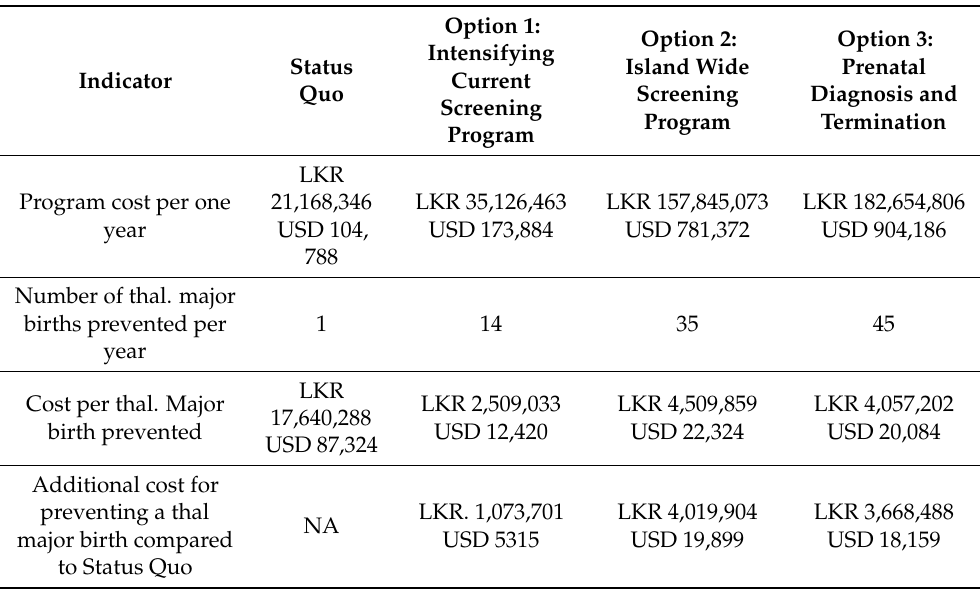
Table 1. Summary of data analysis: Benefit-cost ratios from the Ministry of Health perspective is shown for the status quo and the three novel policy